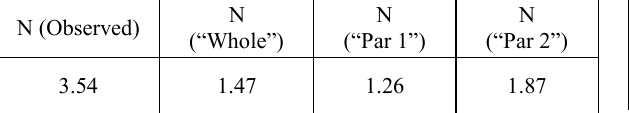
Table 5. Total Nitrogen results from model simulation, considering all pressures (total simulation duration average).